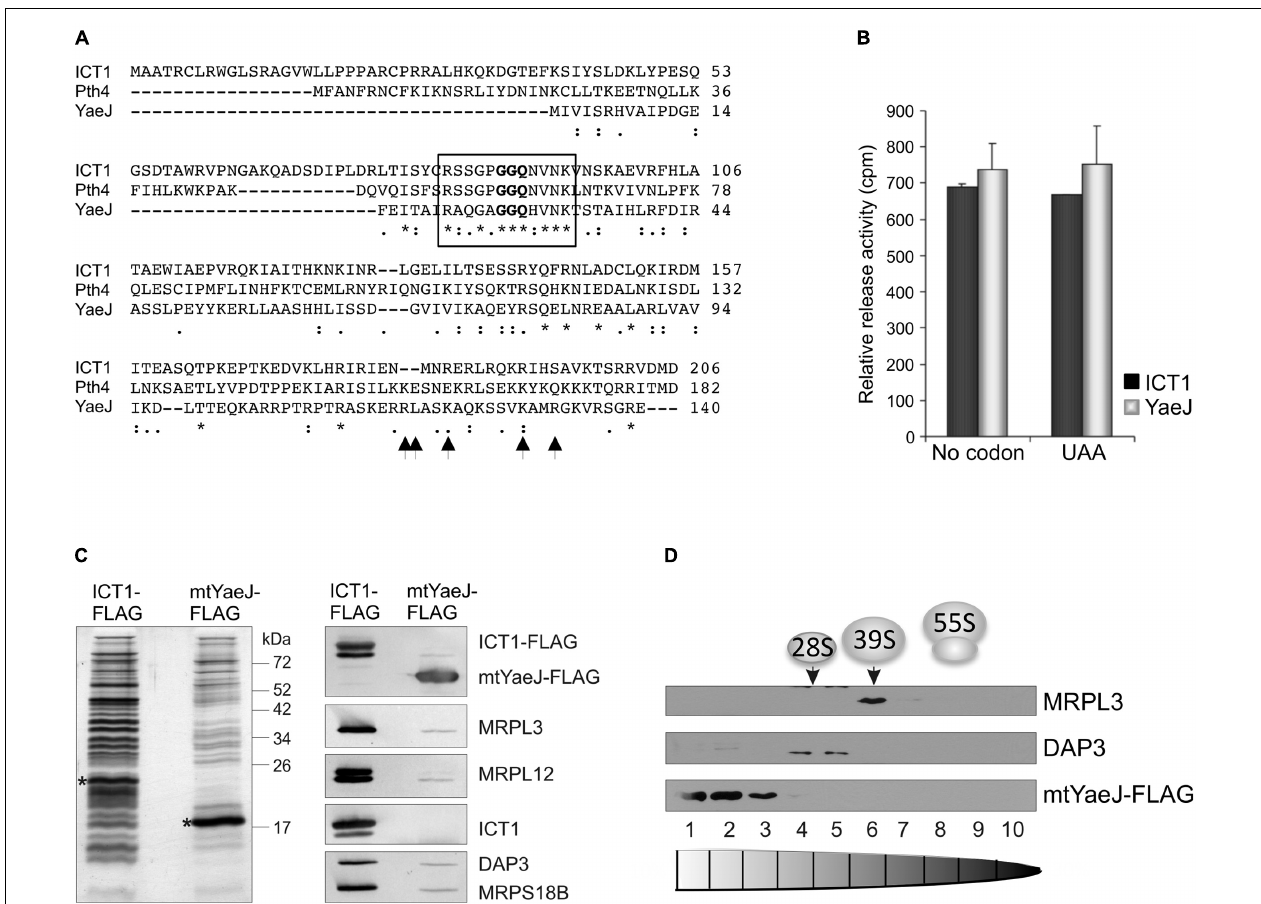
staining (left panel, FLAG protein indicated by *) or western blot (right panel). Antibodies against MRPL3, MRPL12, ICT1, DAP3, and MRPS18B were used to determine the relative levels of coimmunoprecipitated ribosomal proteins. The presence of FLAG tagged protein in each elution was confirmed by anti-FLAG antibodies. (D) Mitochondrially-targeted YaeJ-FLAG does not co-migrate with the 39S LSU. Lysate (700 μ g) of mtYaeJ-FLAG expressing cells was separated on an isokinetic sucrose gradient. Fractions were analyzed by western blot using antibodies against the 39S LSU (MRPL3) and the 28S SSU (DAP3). The distribution of mtYaeJ-FLAG was determined by applying FLAG antibodies. Methods for panels (B–D) were essentially as described in Richter etal. (2010), except a YaeJ-FLAG construct was used to generate a HEK293T overexpression line instead of the ICT1